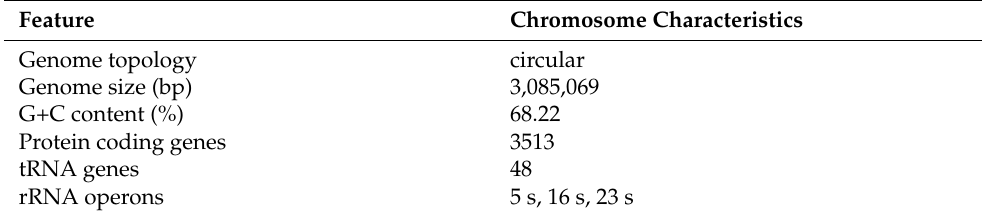
Table 1. General features of Halorubrum sp. 2020YC7